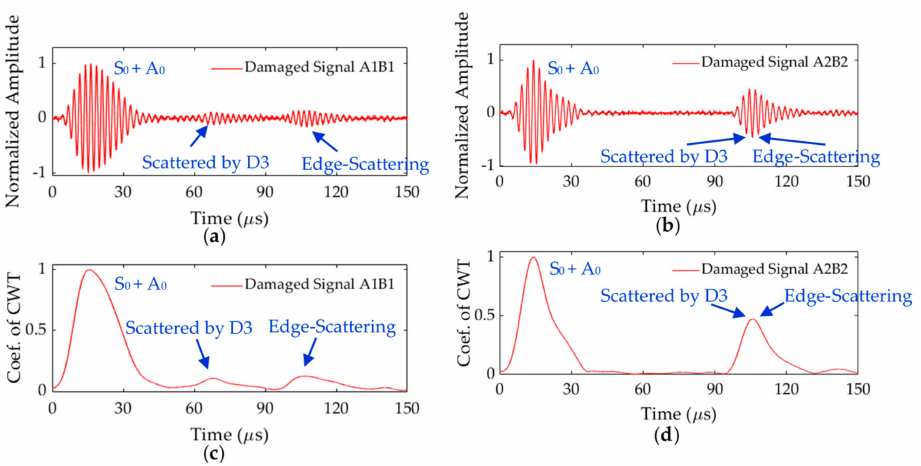
Figure 27. ( a ) Damaged signal at A1B1; ( b ) damaged signal at A2B2; ( c ) coe ffi cient of CWT at A1B1; ( d ) coe ffi cient of CWT at A2B2.